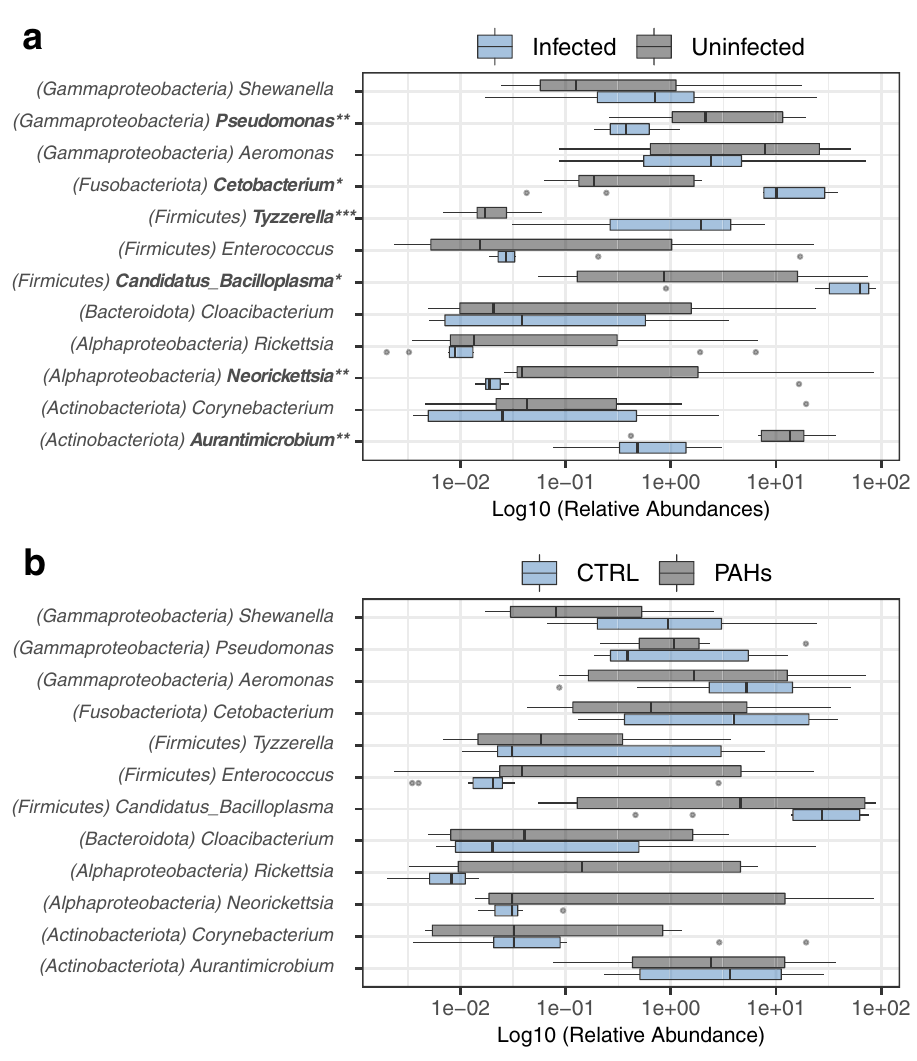
Figure 4. Relative abundance of the main bacterial genera in gut bacterial communities. The relative abundances of the main bacterial genera were compared between infected and uninfected chub ( a ) and between controls and PAH-exposed chub ( b ). The dot color refers to the parasitic status (gray: uninfected and blue: infected) or the PAH exposure (gray: PAH-exposed and blue: controls). Mann Whitney Wilcoxon tests were used to compare the groups for each taxon and significantly differentially abundant taxa were highlighted in bold on the plot. The p values were adjusted with Benjamini–Hochberg corrections to correct for multiple testing (*: p < 0.05; **: p < 0.01 and ***: p < 0.001) (see Table S6 for details of adjusted p